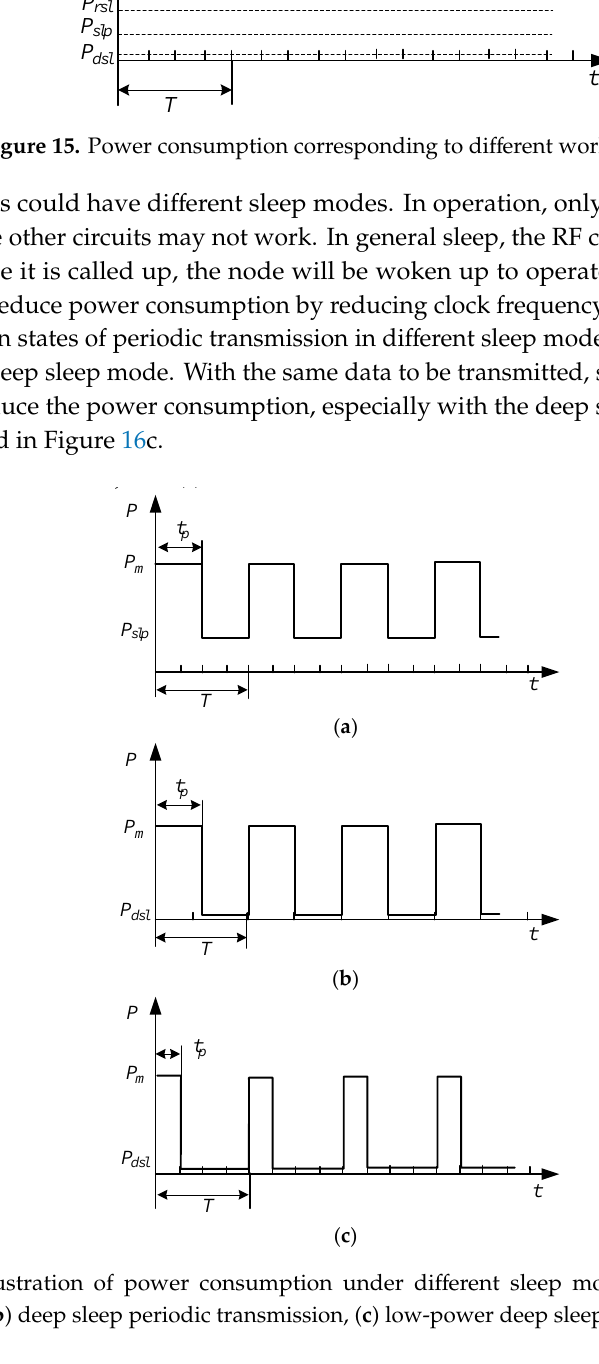
Figure 16. Illustration of power consumption under different sleep modes: ( a ) sleep periodic transmission, ( b ) deep sleep periodic transmission, ( c ) low-power deep sleep periodic transmission.